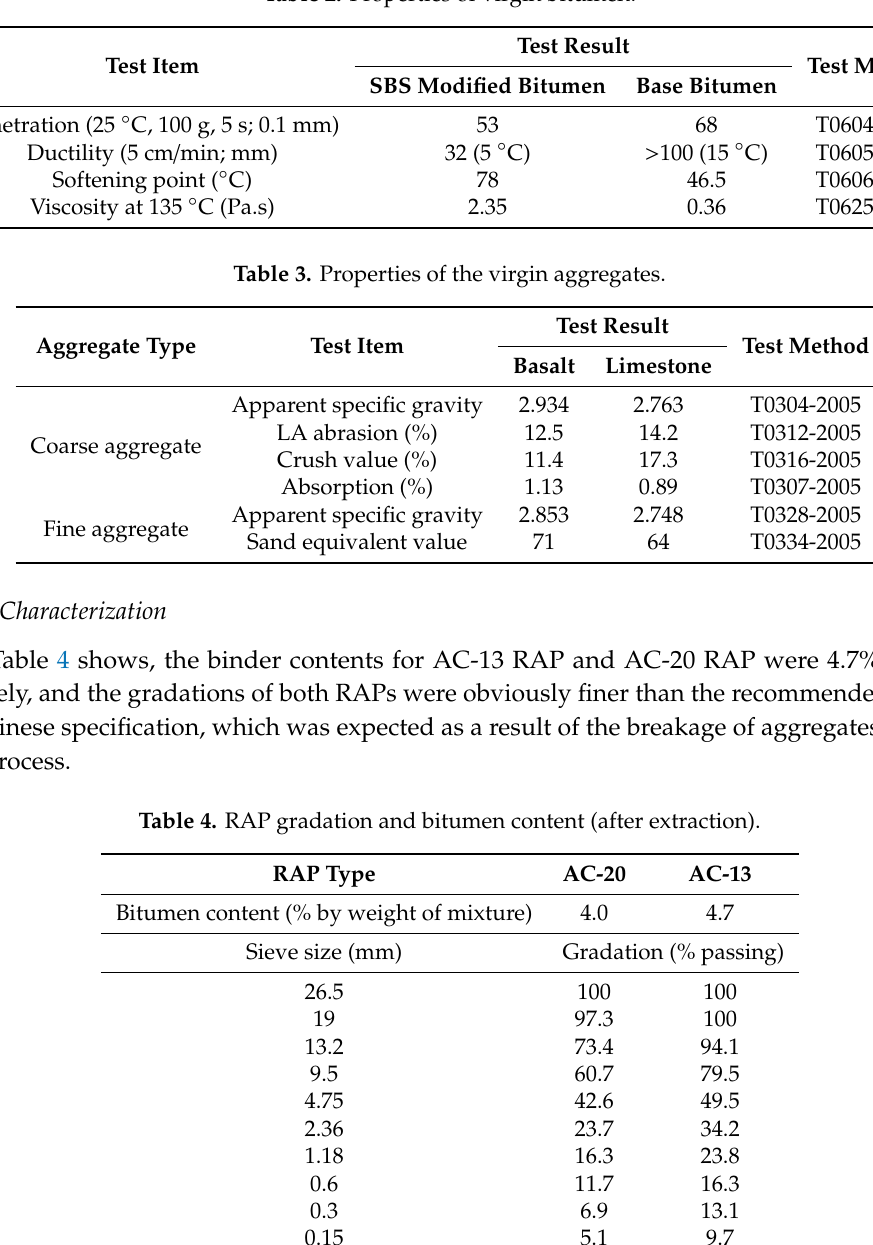
Table 2. Properties of virgin bitumen.